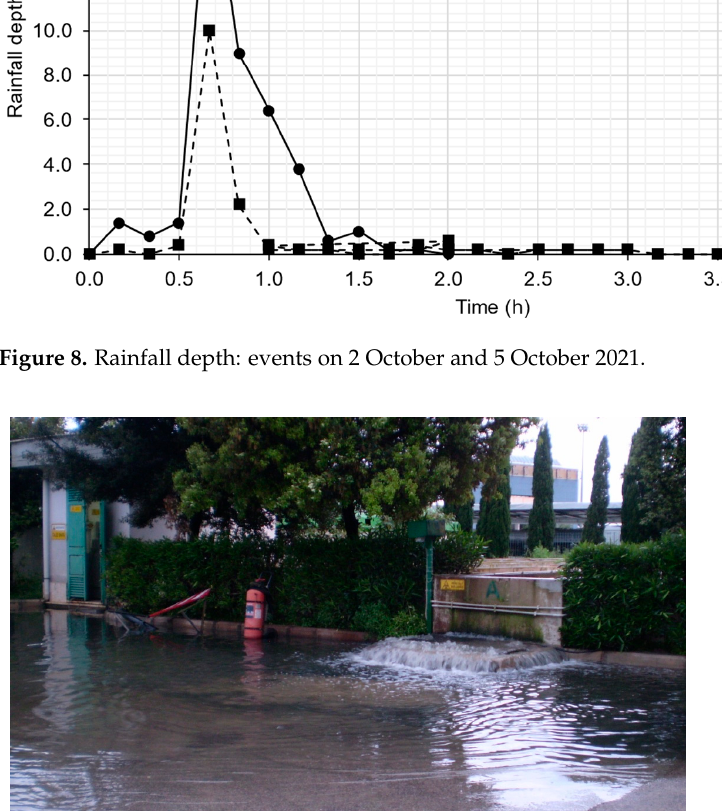
Figure 9. Overflow of the reception tank at the Water Treatment Plant.